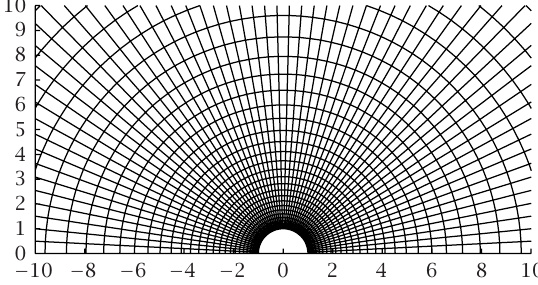
Figure 3.1 . Figure showing the type of grid